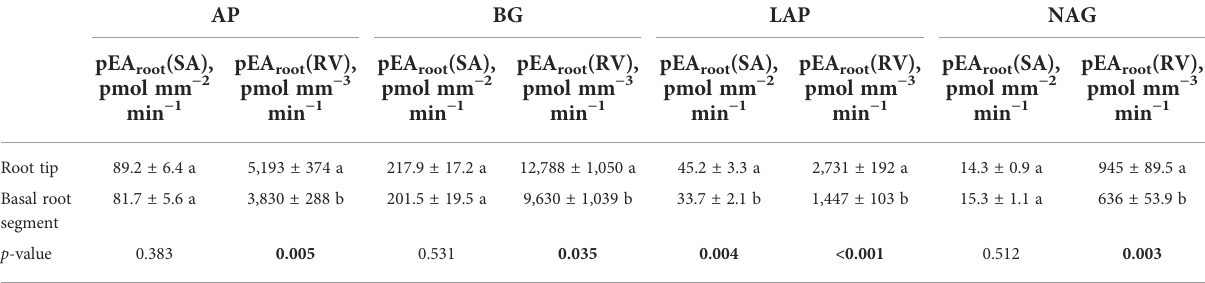
TABLE 3 Potential root enzyme activities (pEA root ) of acid phosphatase (AP), b -glucosidase (BG), leucine-amino-peptidase (LAP), and N-acetyl- glucosaminidase (NAG) of lateral roots ’ root tips and basal root segments in grafted cucurbit species.